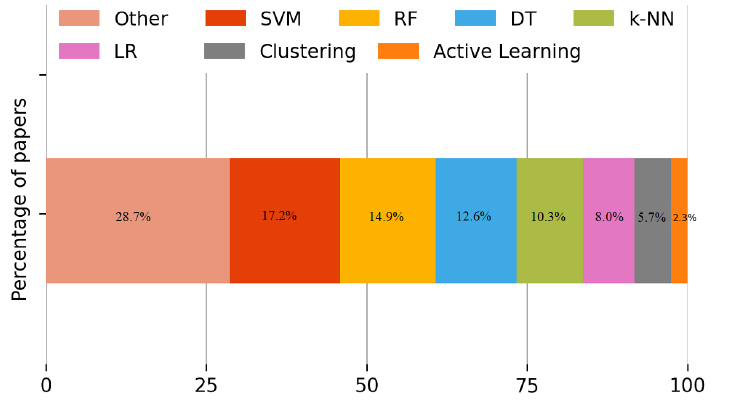
Figure 22. Percentage of papers per ML category of algorithms found in the sample studied. The most used ML techniques are SVM, RF, DT and K-NN.